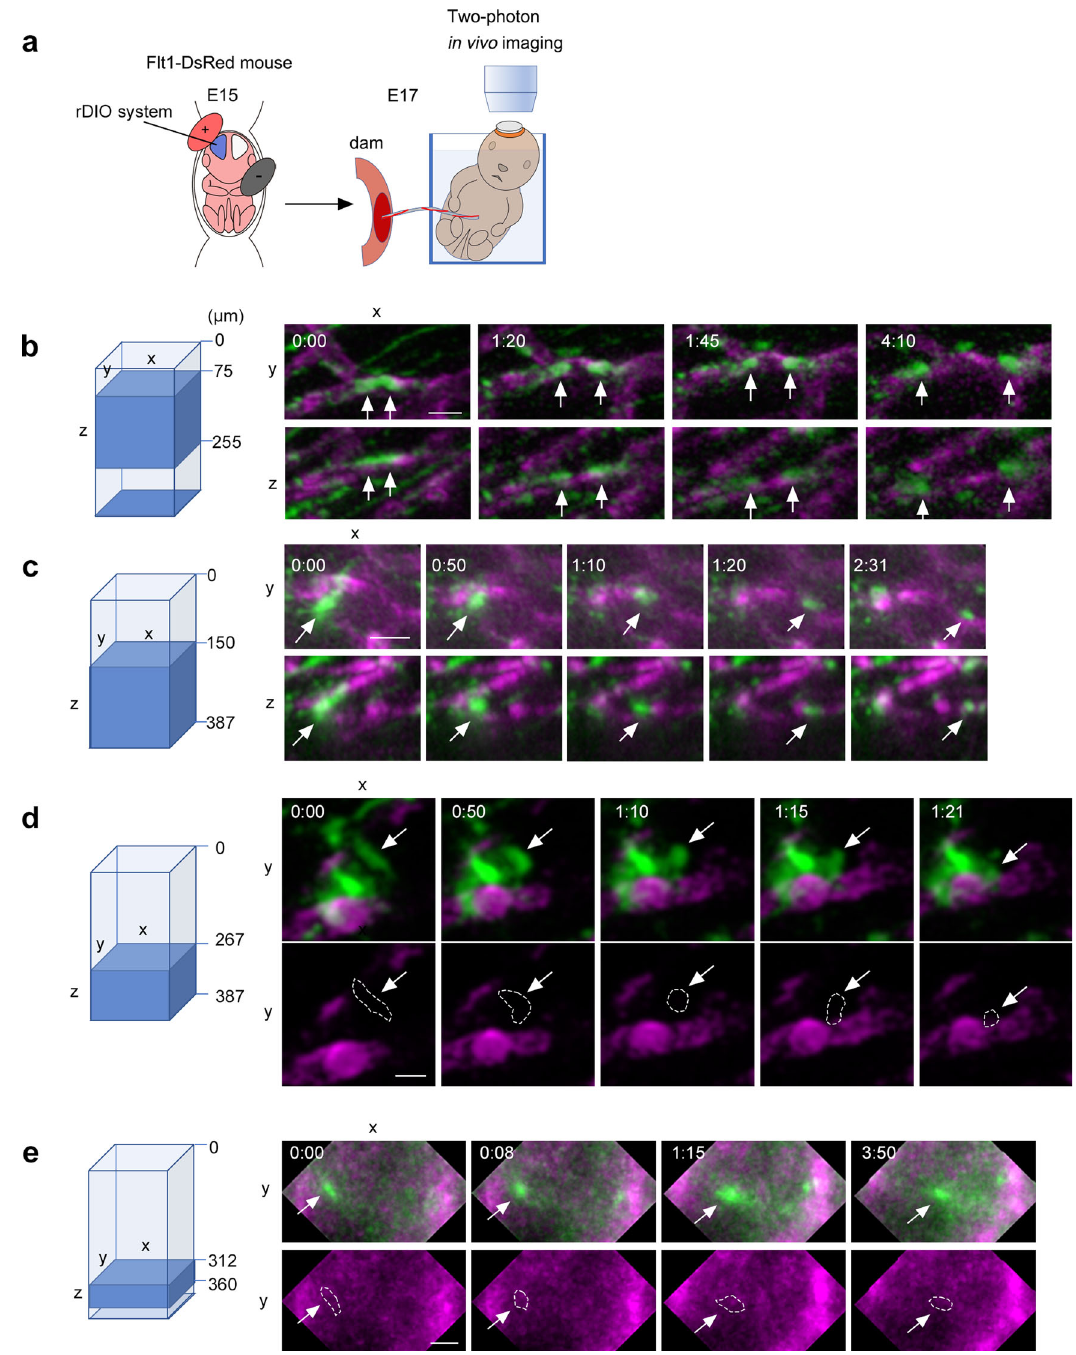
Fig. 4 | Two-photon in vivo imaging of blood vessel-guided migration and blood vessel-independent migration. a Schematic illustration of two-photon imaging of living embryos we performed. We introduced the rDIO system into Flt1- DsRed mice at E15 and performed imaging 2 days later. ( b – e ) Reconstructed two- photon images. The range of Z axis to reconstruct the image is shown on the left (blue region, the scale of depth from the brain surface is shown on the right side of thebox).Thetimestampsareshowninh:mmformat.( b , c )Twoexamplesofinvivo imaging showing blood vessel-guided migration of GFP-positive cells (arrows). The